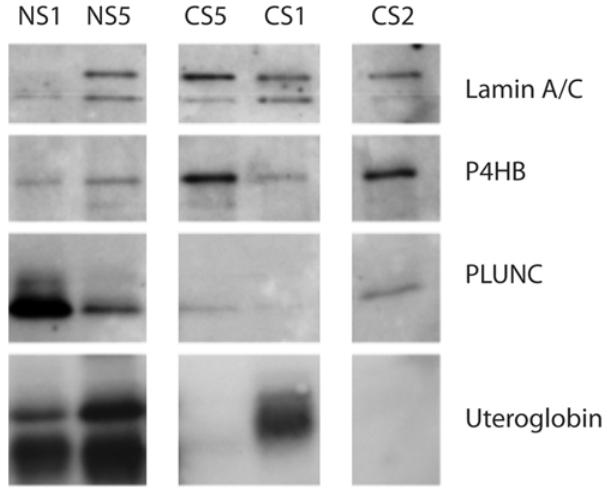
Figure 2. Western blot validation of proteins detected by proteomics in never and current smokers. Western blotting shows significantly higher levels of PLUNC in the never smokers. Higher levels of uteroglobin were also observed in never smokers, although there was heterogeneity among the current smokers. There was a small increase in P4HB in two of the current smoker samples.